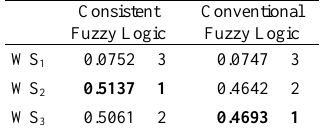
Table 7. Result comparison for Case 1